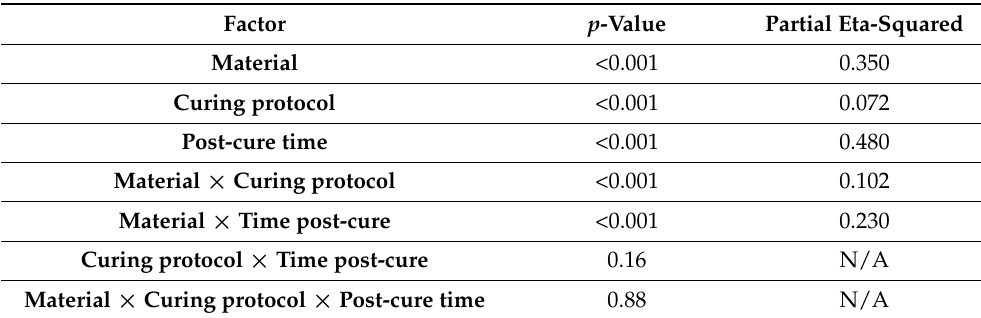
Table 2. Statistical significance ( p -values) and practical significance (partial eta-squared values) of the factors “material”, “curing protocol”, and “post-cure time” for degree of conversion. Factor p